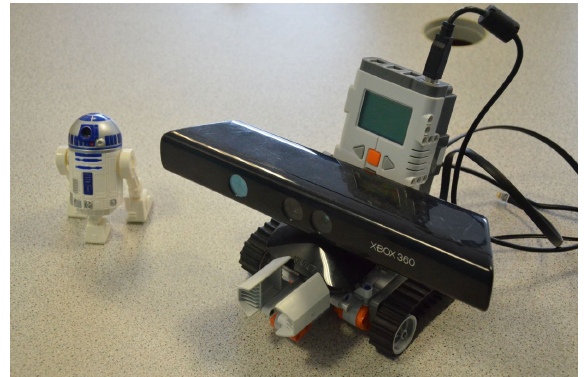
Figure 5. CuriousMind: a LEGO Mindstorm vehicle and a Kinect